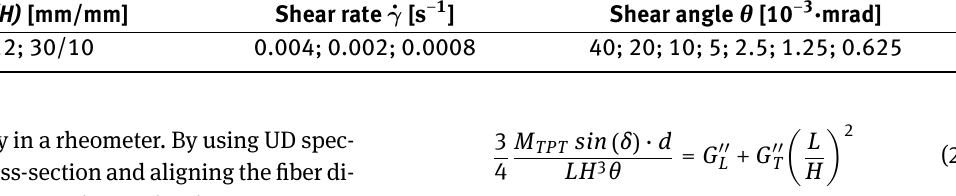
Table 1: Test parameters – thin plate torsion tests Aspect ratio (L/H)